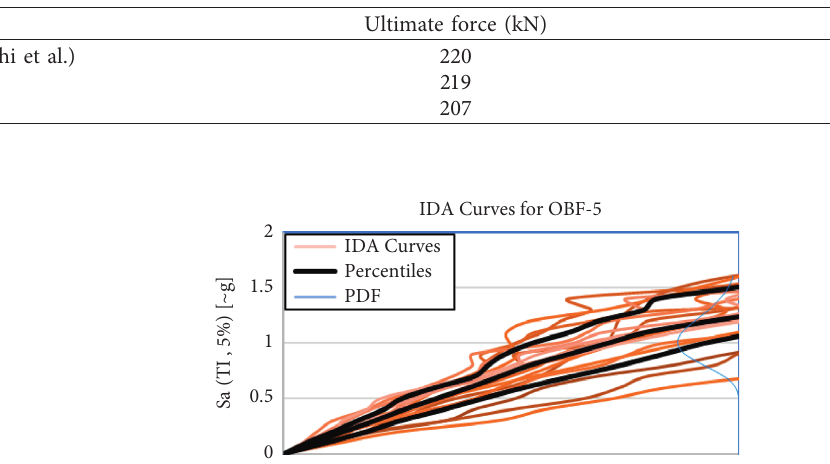
Table 8: Results of software modeling and validation by the experiment of Shi et al.